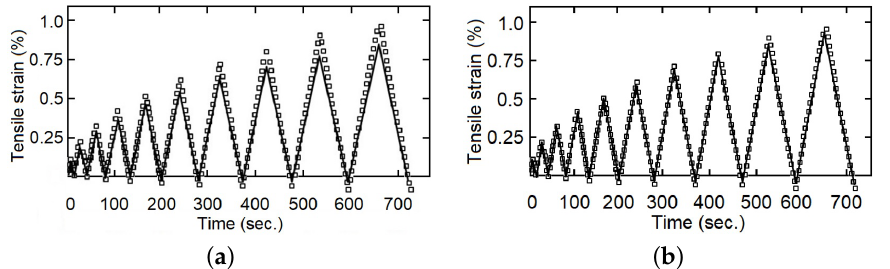
Figure 9. Tensile strain for loading–unloading test, one specimen with 14 wt%, experimental data in dots and model response in continuous line, ( a ) integer index model, ( b ) fractional index